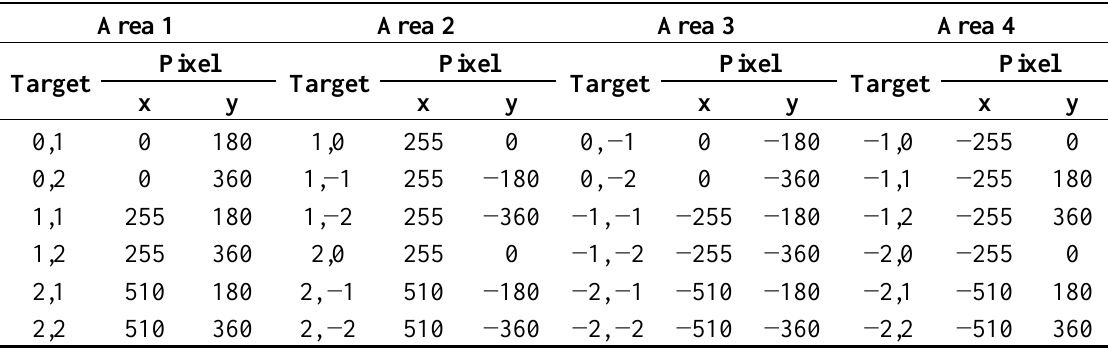
Table 2. Pixel locations of each training